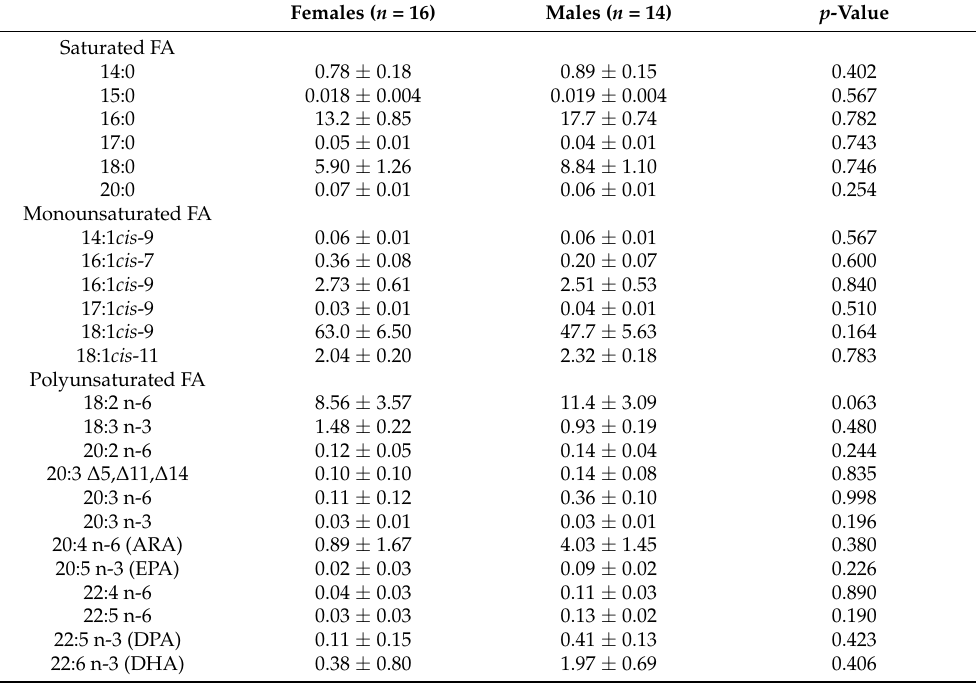
Table 1. Total fatty acid (FA) profile (% of total FA) in muscle ( m. biceps femoris ) of male and female edible dormouse ( Glis glis ).